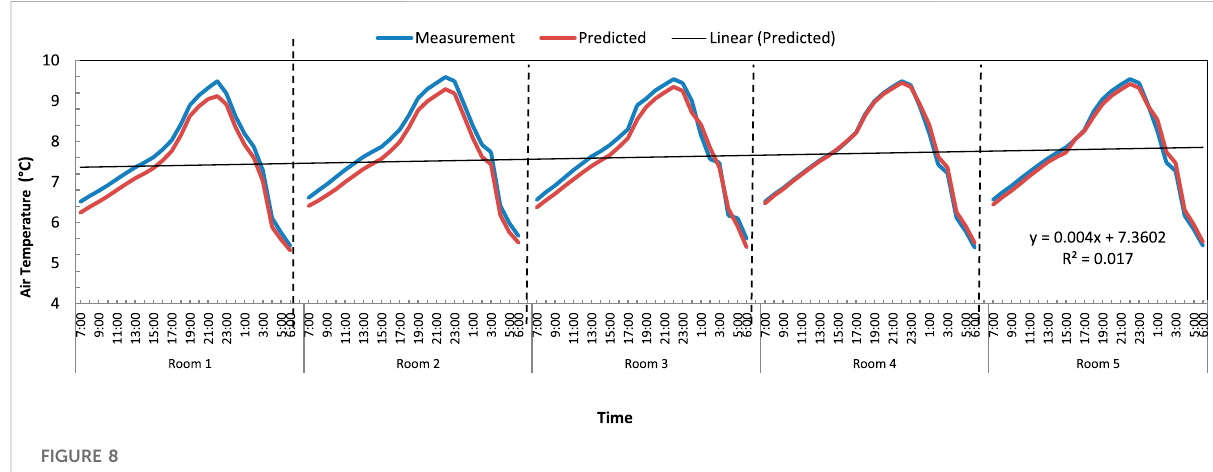
FIGURE 8 Measured temperature versus predicted temperature in January 2021.